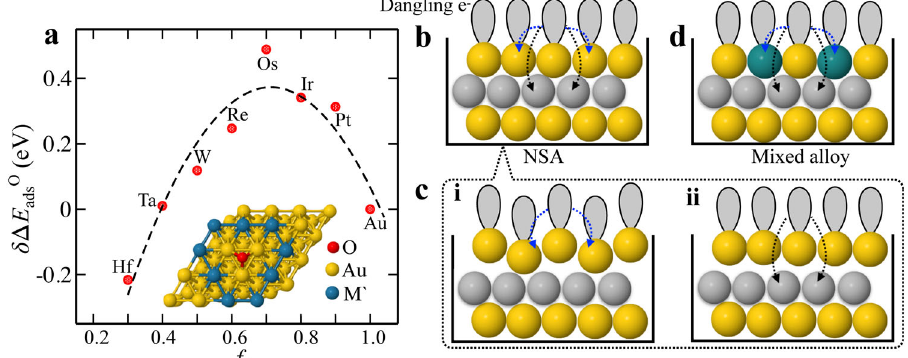
transfer within the surface and subsurface layer atoms. Host atoms, guest atoms in the subsurface layer, and guest atoms in the surface layer are shown in yellow, gray, and teal, respectively.